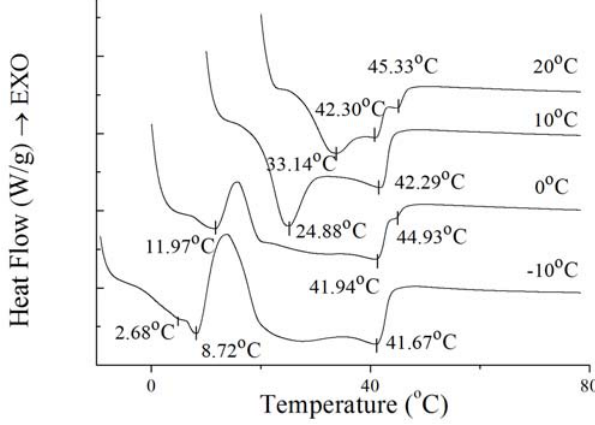
Figure 8. Melting thermogram at 5 °C/min on PS at the end of isothermal crystallization at various temperatures of crystallization.